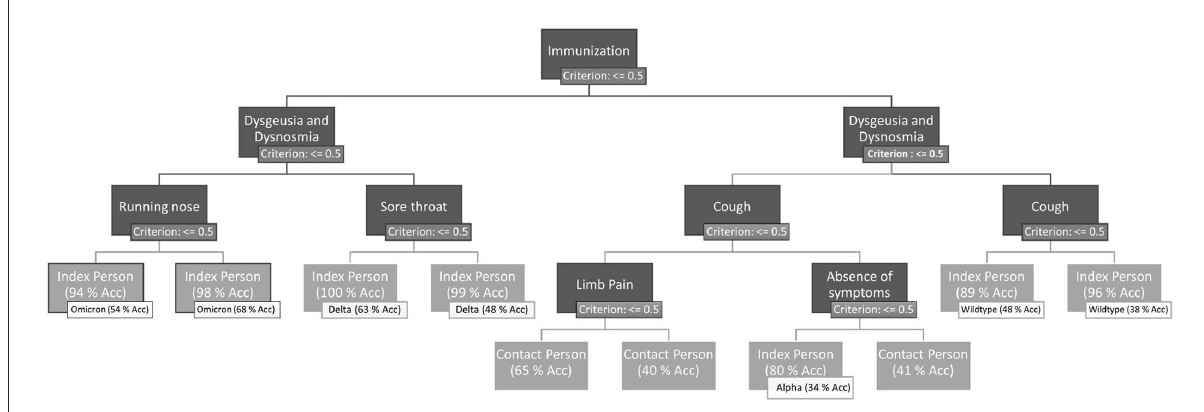
FIGURE2 Final decision tree after hyperparameter optimization, trained on the whole training dataset. Leaves of the DT are evaluated (accuracy of the examples of the leaves) on the one hand for the binary classification problem index vs. contact person and on the other hand for the more complex problem prevailing dominant variants vs. contact persons. If a symptom is present, the right path of the node is chosen. The left path represents the absence of the symptom. Immunization is treated as a symptom. Therefore, immunization = 1 means that the person has no immunization by a previous infection or any